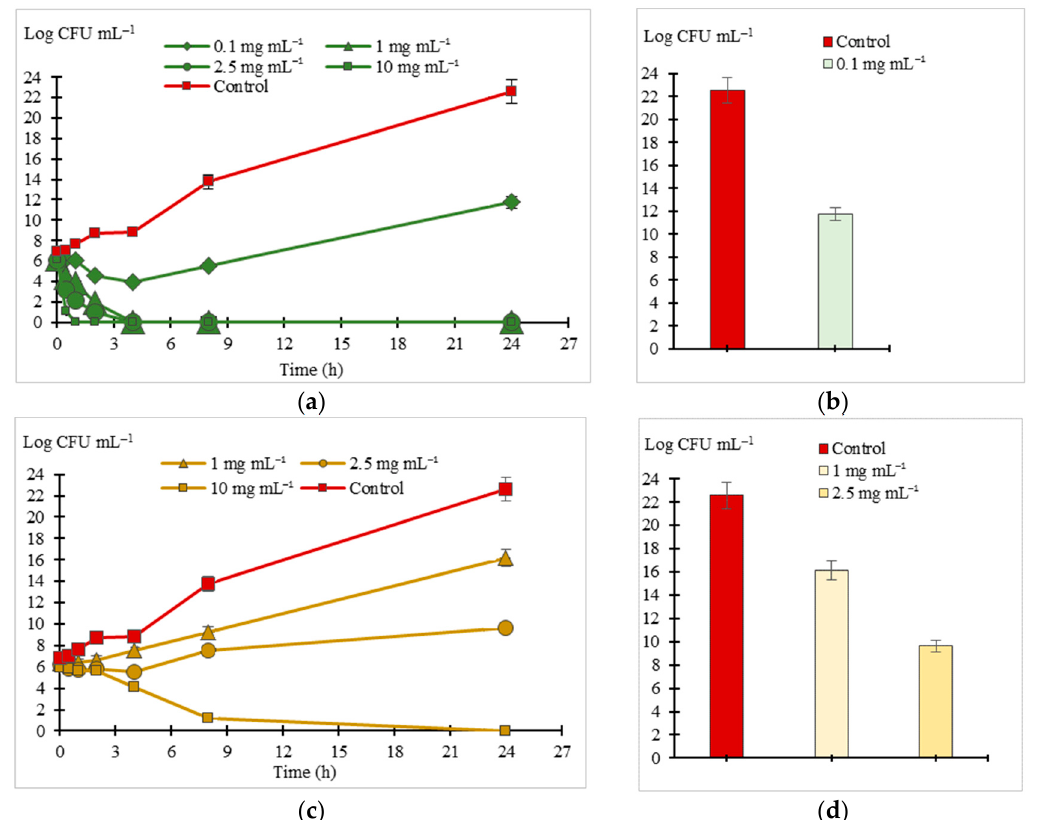
Figure 2. Time–kill curves for S. aureus ATCC 29213 at various concentrations of supercritical extracts obtained from: ( a ) H. salicifolius and ( c ) H. tuberosus with water as a co-solvent (CO 2 + H 2 O extracts). Bacterial population density after 24 h exposure to various concentrations of the CO 2 + H 2 O extracts obtained from: ( b ) H. salicifolius and ( d ) H. tuberosus . Mean values ± standard deviations are presented.